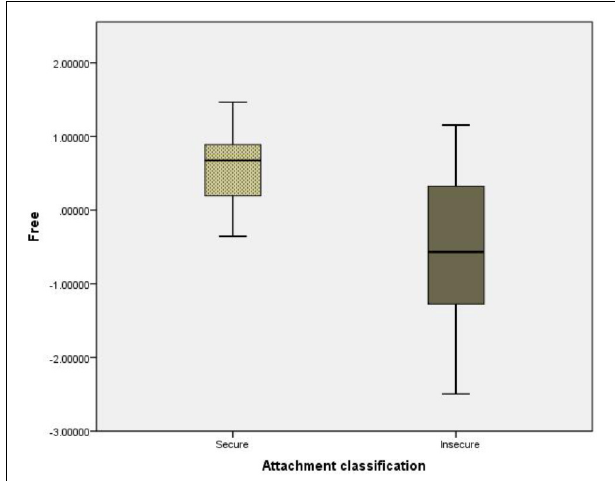
FIGURE 3 | Difference between secure and insecure participans on the free MG behavior. Distribution of the free MG behavior among participants with secure and insecure attachment styles. Box-Whisker plots of the distributions of the free measure for secure ( N = 22) and insecure ( N = 26) participants are shown. Participants were tagged as secure/insecure based on their score on the AAI. The dotted gray (for secure) and dark gray (for insecure) boxes span the range from the first to the third quintiles, around median values (black line). The whiskers represent the minimal and maximal values.